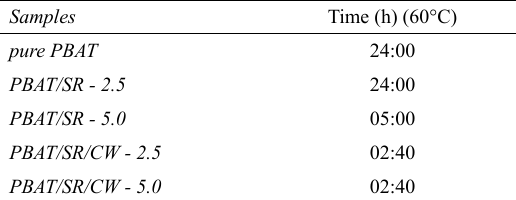
Table 2. Drying conditions after the first extrusion step. Samples